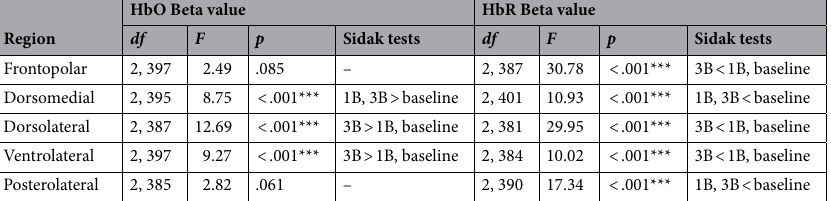
Table 6. Linear mixed model results for the main effect of load on changes in oxyhemoglobin (HbO) and deoxyhemoglobin (HbR) concentrations. 1B = 1-back; 3B = 3-back. The “=” sign implies no significant difference in HbO or HbR changes between WM load levels in the corresponding region. The p value threshold was corrected to 0.01 (i.e., 0.05/5 regions), and Sidak tests were used for post-hoc testing. *** p <